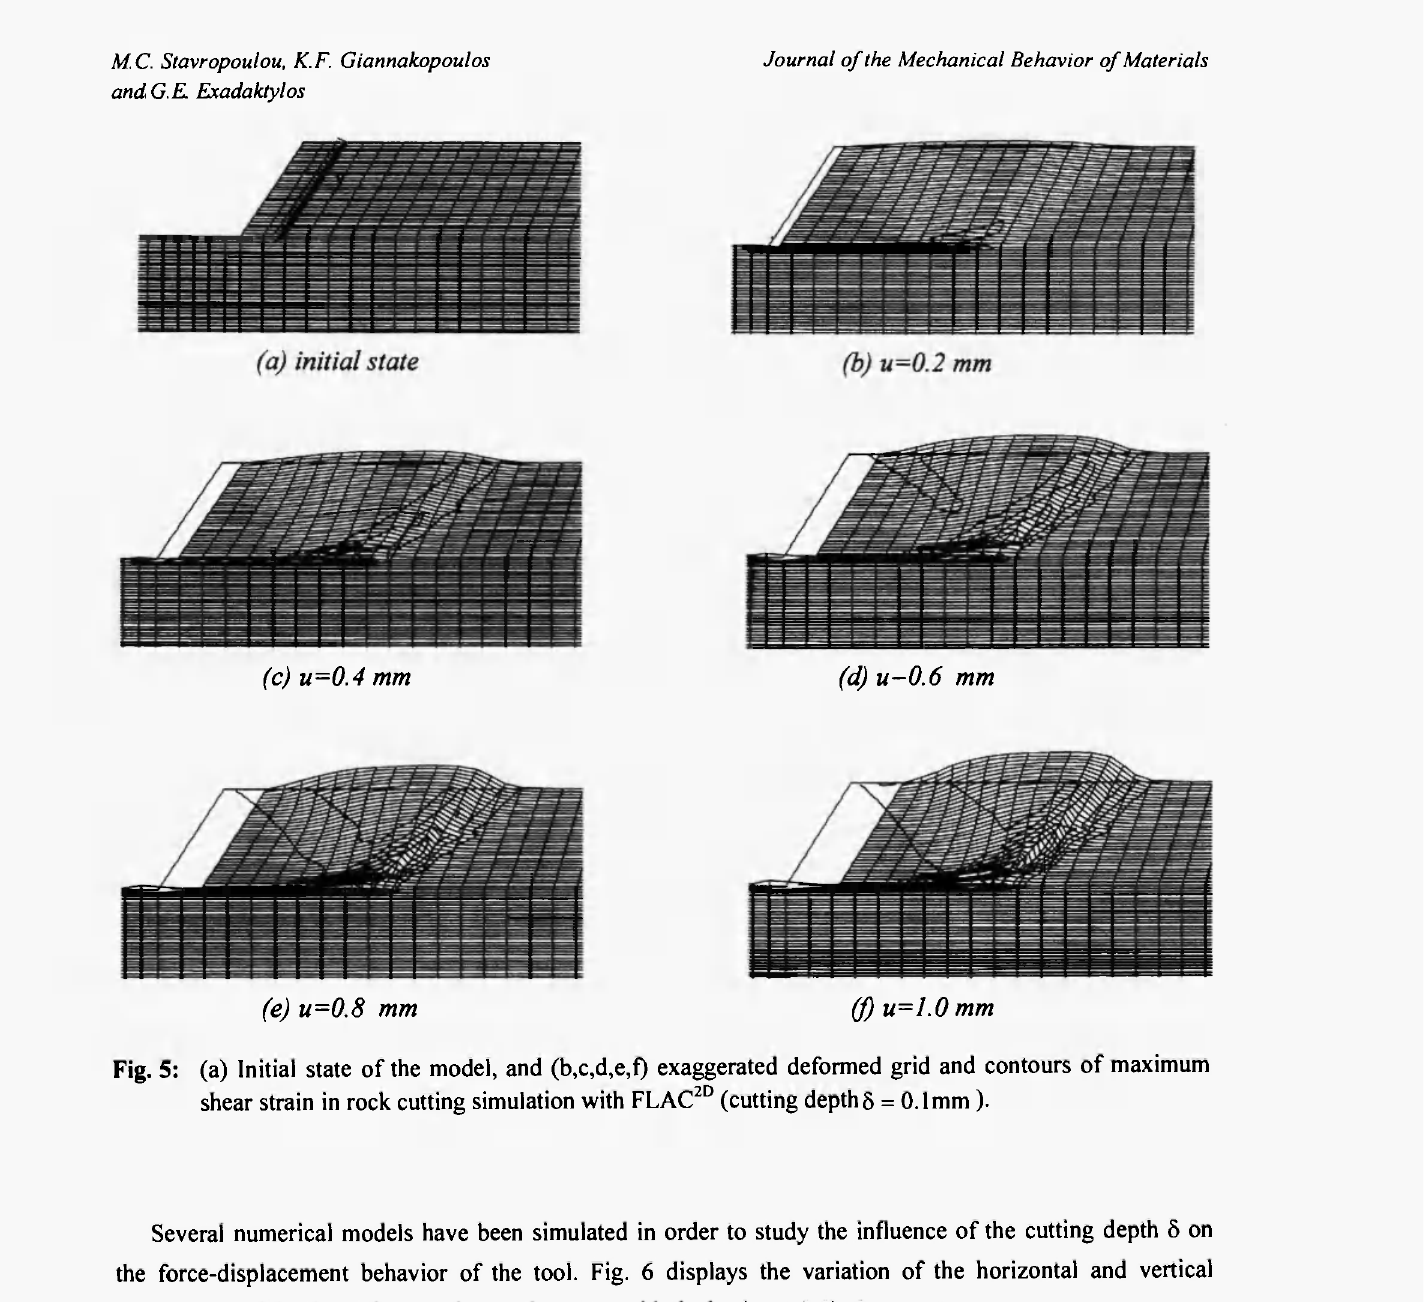
Fig. 5: (a) Initial state of the model, and (b,c,d,e,f) exaggerated deformed grid and contours of maximum shear strain in rock cutting simulation with FLAC 20 (cutting depth 5 = 0.1 mm